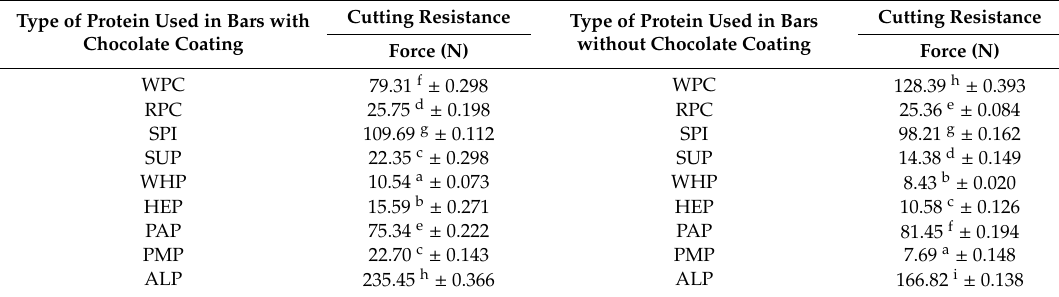
Table 3. E ff ect of di ff erent protein sources on high-protein bars cutting resistance. Type of Protein Used in Bars with Chocolate